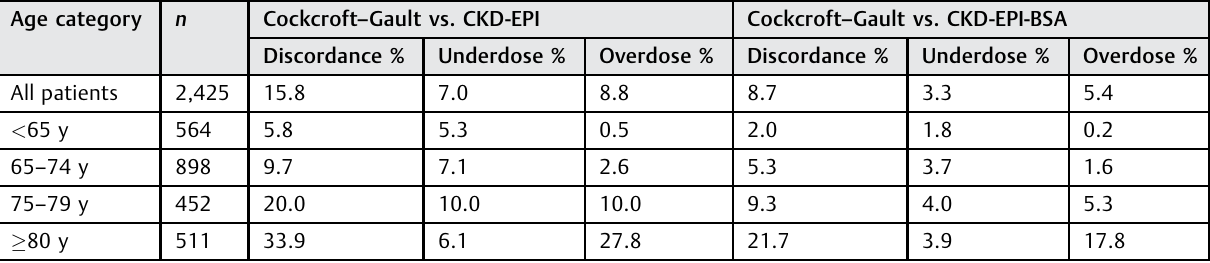
Abbreviations: CKD-EPI, chronic kidney disease epidemiology initiative equation; CKD-EPI-BSA, chronic kidney disease epidemiology initiative equation adjusted for body surface